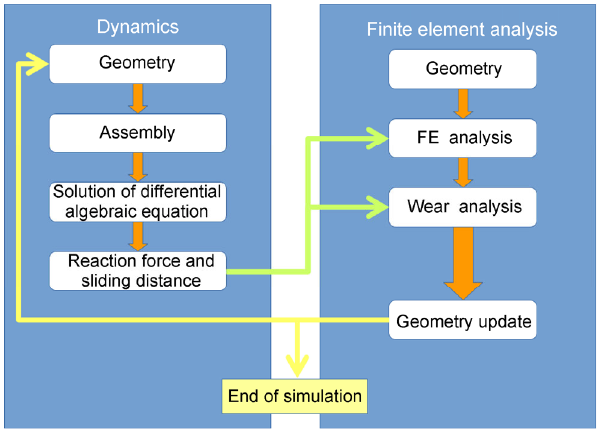
Fig. 12 Multibody system using slider crank mechanism with clearance.